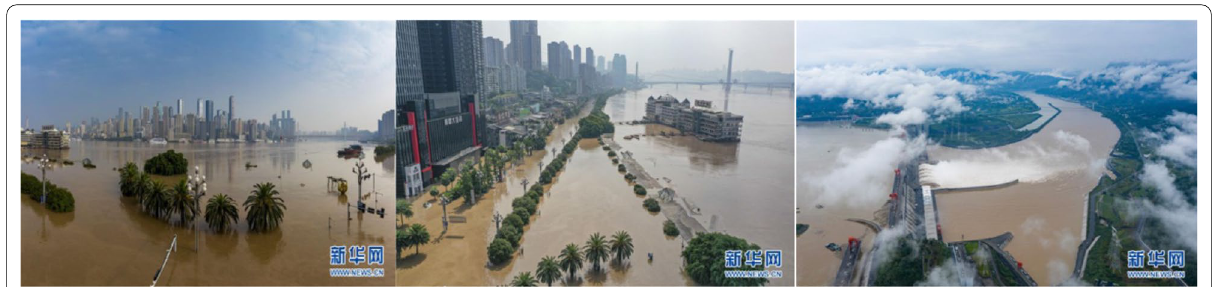
Fig. 2 Severe floods in the Yangtze River Basin in